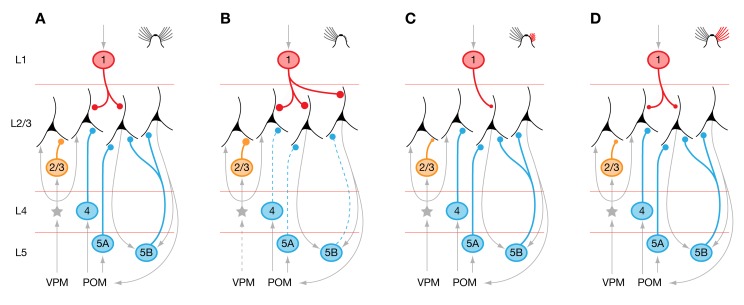
Plasticity of inhibitory wiring motifs in a functional context.(A) L2/3 pyramidal cells in barrel cortex of mice with intact whiskers receive feed-forward (yellow), feedback (blue), and top-down inhibition (red). Interneurons providing these different forms of inhibition are located in different cortical layers, where they are driven, respectively, by thalamocortical afferents and cortical excitatory neurons (L4 and L2/3 interneurons, yellow); by intracortical or cortico-thalamo-cortical loops (L4 septal and L5B interneurons, blue); and by interareal excitatory connections terminating in L1 (red). (B) Whisker trimming leads to motif-specific changes in connection probabilities: existing inhibitory connections from L4 and L5B are eliminated, whereas new inhibitory connections from L1 are formed. (C) Partial whisker regrowth leads to overcompensation of deprivation-induced changes in connection probabilities and a large reduction in the strength of inhibitory connections from L1 and L2/3. (D) Full whisker regrowth restores connection probabilities to baseline. The strength of inhibitory connections from L1 and L2/3 recovers only partially.